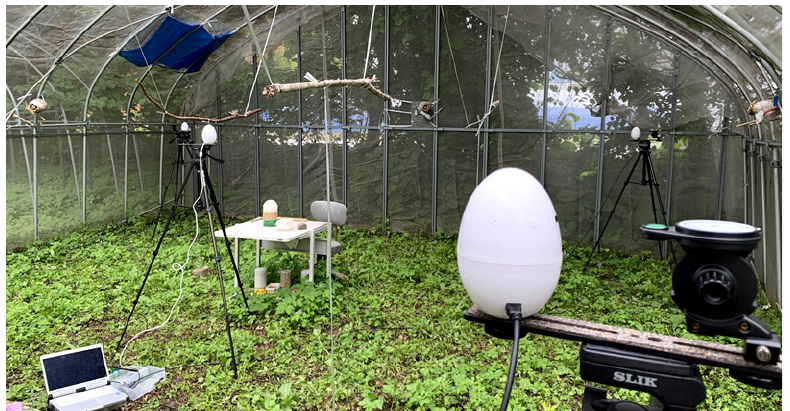
Figure 1. Experimental environment employing the HARKBird program.